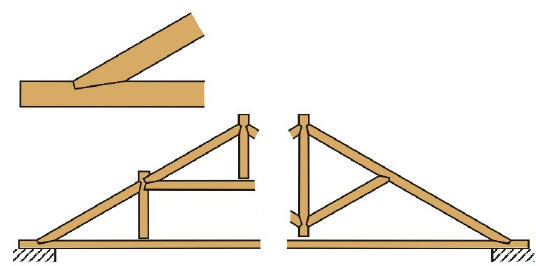
Figure 1. Typical birdsmouth joint and Mediterranean roof structure schemes.